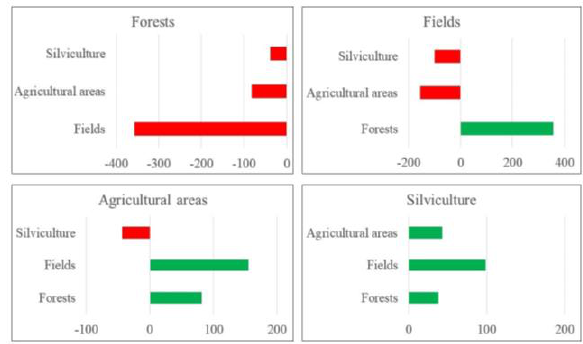
Figure 7. Transition of land use and land cover classes in the Chapadinha microregion (2009-2019